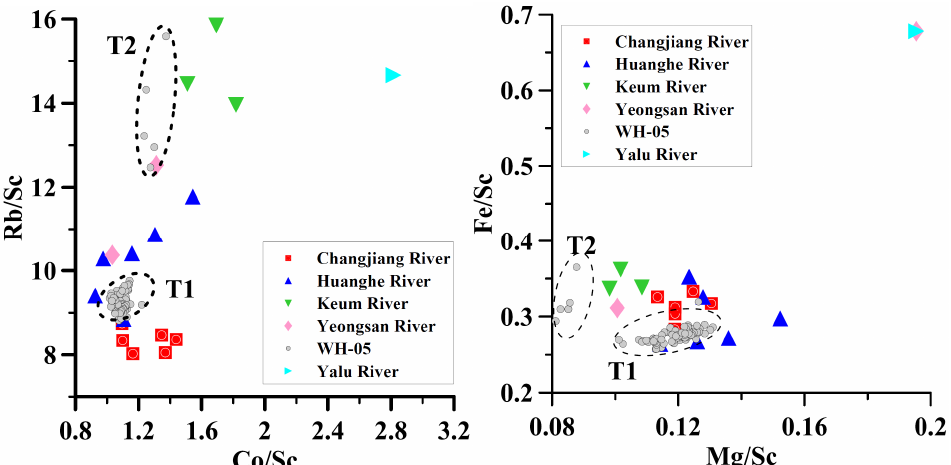
Figure 9. Rb/Sc-Co/Sc and Fe/Sc-Mg/Sc scatter diagrams of sediments from core WH-05 and surrounding rivers. Note: The data of Changjiang, Huanghe, Keum, and Yeongsan rivers are from [26,27]; and those of Yalu River are from [2,24,25]. T1: samples in 0~−17.8 m of Core WH-05; T2: samples in−17.8~−18.2 m of Core WH-05.